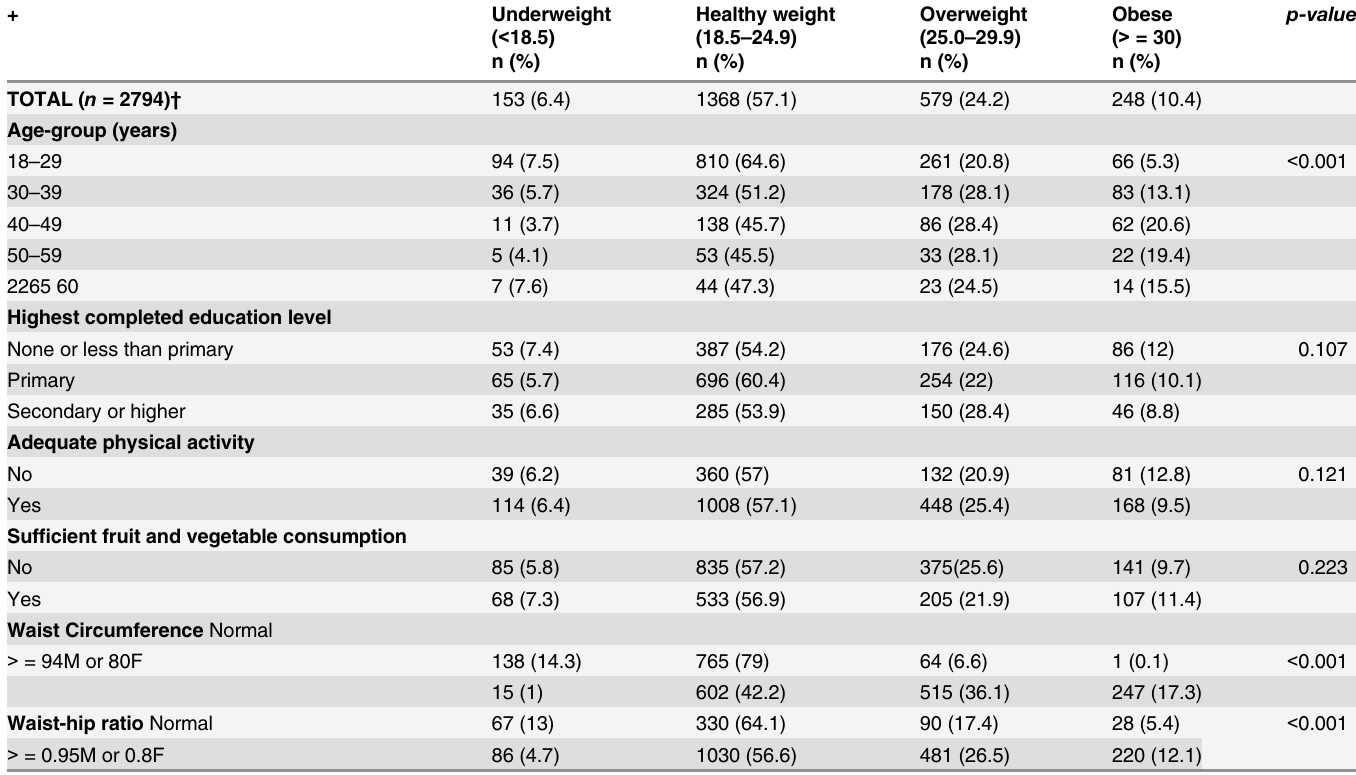
Table 4. Body mass index by individual characteristics for female adults 18 years and older, Nairobi